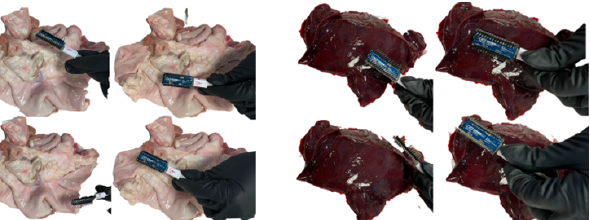
Figure 9. Frames concerning the acquisition of color data from the stomach and liver to detect the intensity of the red, green, and blue colors of each tissue subjected to the